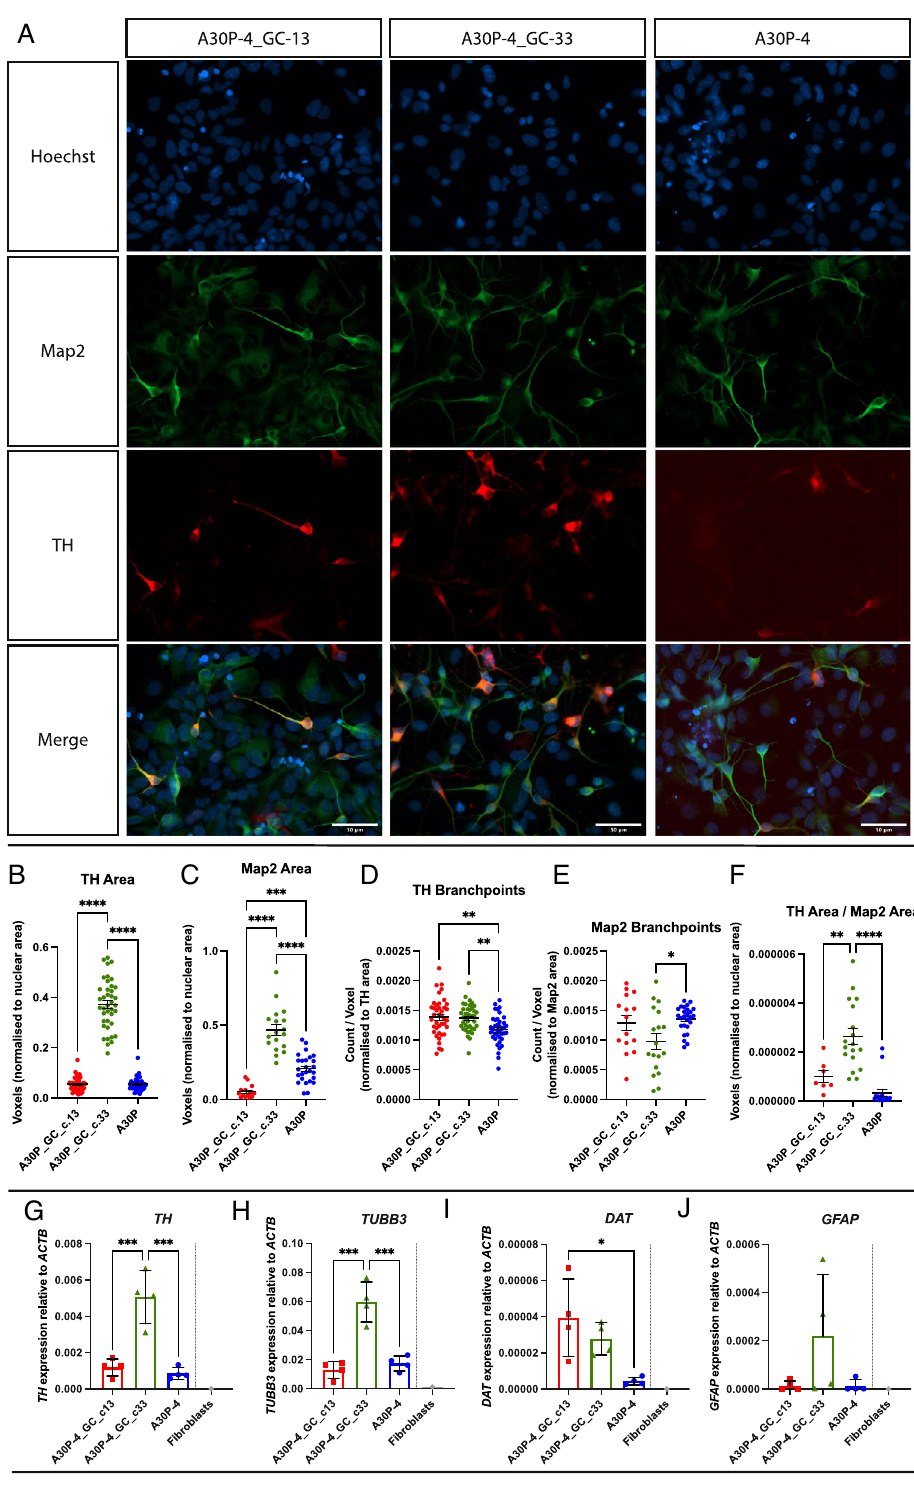
Figure 1. Morphometric analysis of TH network in d30 neurons. ( A ) Representative image of a maximum intensity projection of a Z-stack fluorescently labelled with Map2 and TH antibodies. Images taken using a ×25 objective, scale bar is 50 μM. Identification and quantification of parameters: ( B ) TH Area, ( C ) Map2 Area, ( D ) TH Branchpoints, ( E ) Map2 Branchpoints and ( F ) TH Area/Map2 Area were determined. Four biological replicates were used for the analysis with a minimum of six Z-stacks analysed by replicate. The graphs displayed in columns show data points that refer to the average data per Z-stack. Relative quantification in the patient-derived neurons of: ( G ) TH , ( H ) TUBB3 , ( I ) GFAP and ( J ) DAT . Each data point refers to 4 independent biological replicates. For all statistical analyses, an ordinary one-way ANOVA was performed with Tukey’s post-hoc multiple comparison test. Graphs ( B – F ) were plotted as mean ± SEM; graphs ( G – J ) were plotted as mean ± SD. *p < 0.05, ** p < 0.01, ***p < 0.001 ****p <